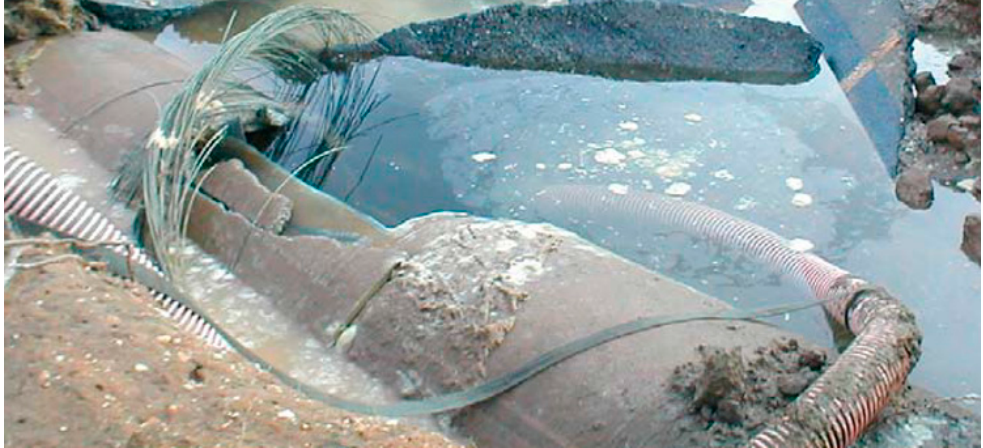
Figure 1. Rupture of the PCC pipe at chainage 0 + 465.80.